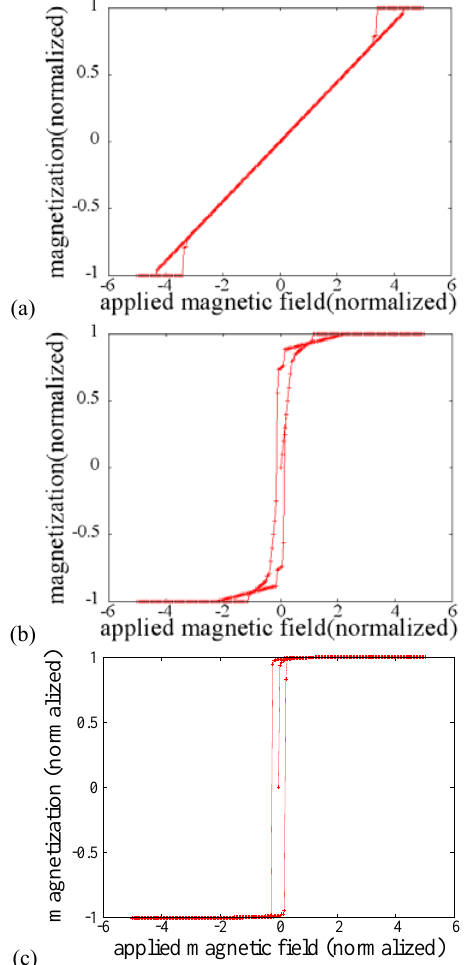
Figure 7: Simulation results of the original ADSMs with (a) 1, (b) 8, and (c) 128 cells.